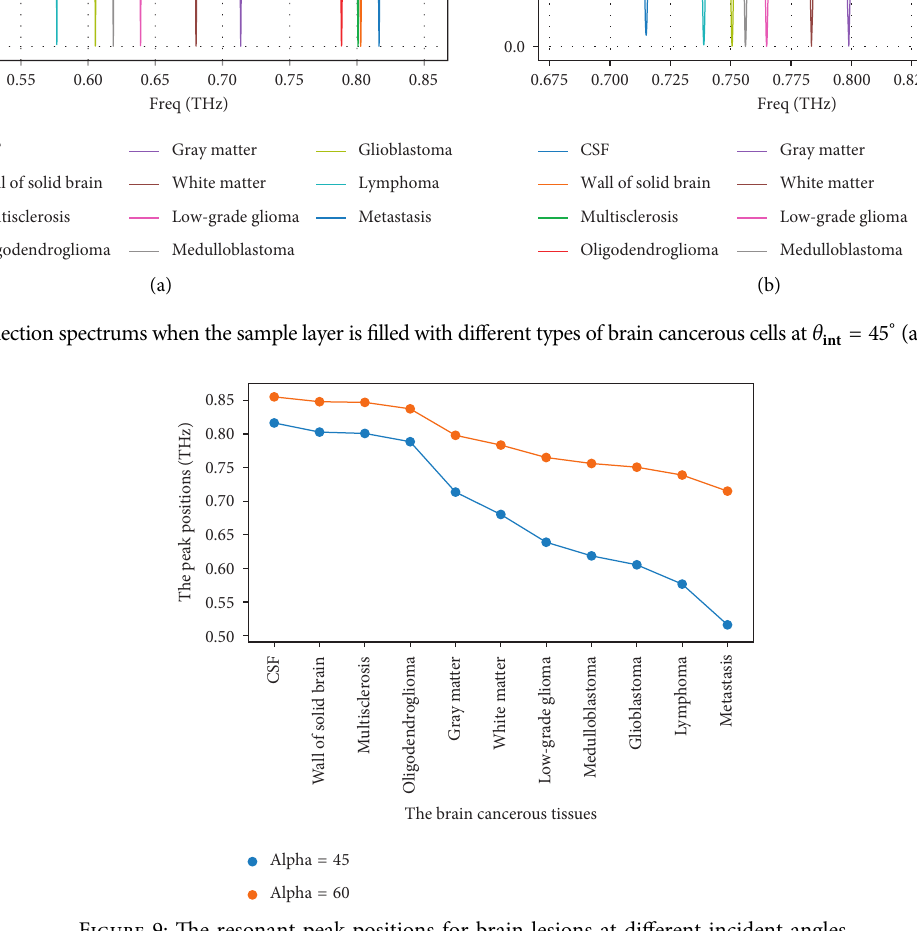
Figure 9: The resonant peak positions for brain lesions at different incident angles. Table 3: The performance parameters S and FOM of designed SSPPs sensors for various cancers at different incident angles. Brain tissues